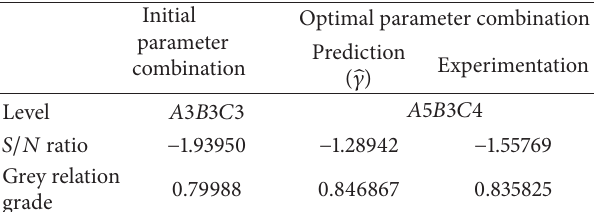
Table 7: Results of confirmation